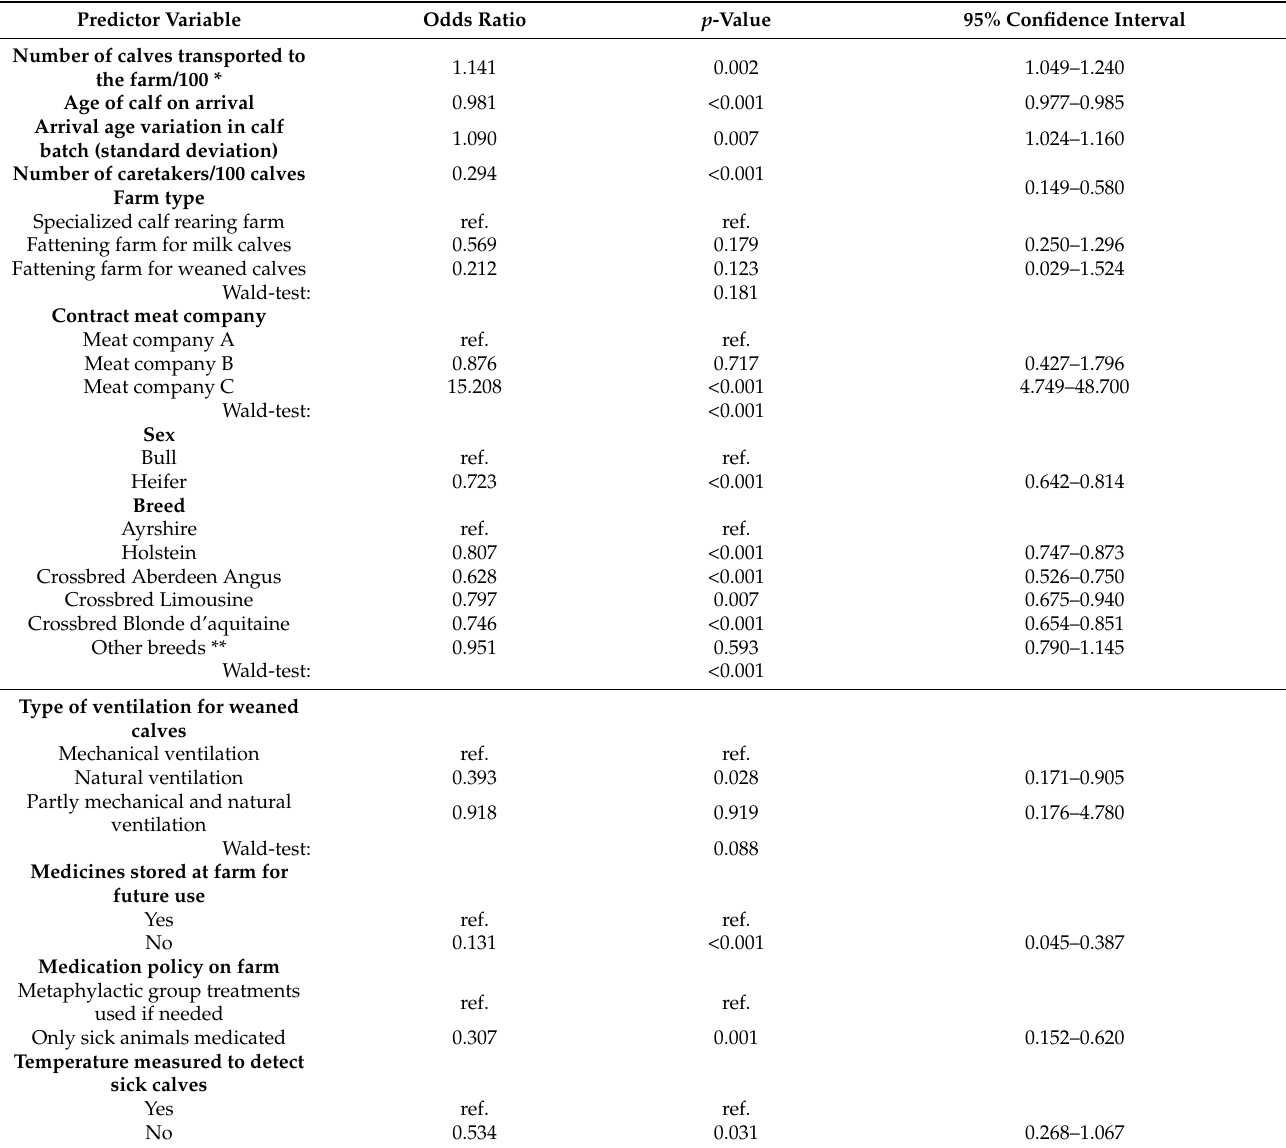
Table 6. Mixed multivariate logistic regression model to study the association between a calf’s odds being medicated at least once during the maximum 180-day follow-up, and predictor variables in 87 herds. Average follow-up time for 28,228 study calves was 150.8 days when early transportation to the finishing units and untimely deaths are taken into